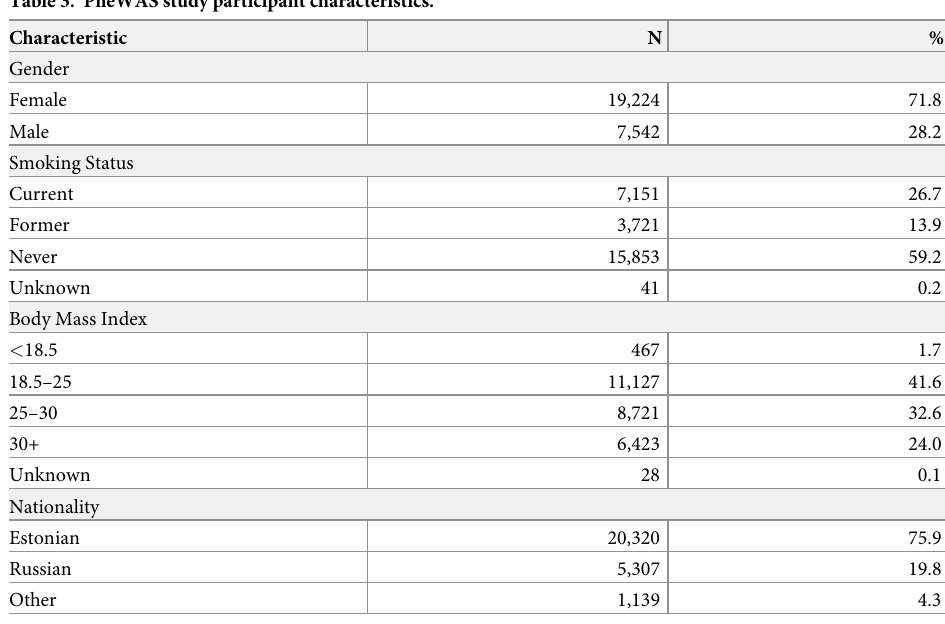
Table 3. PheWAS study participant